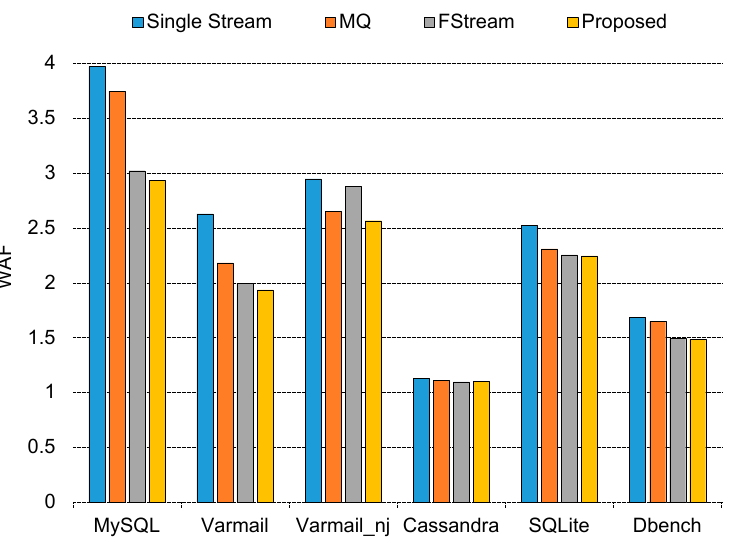
Figure 4. Write amplification factor (WAF) comparison.